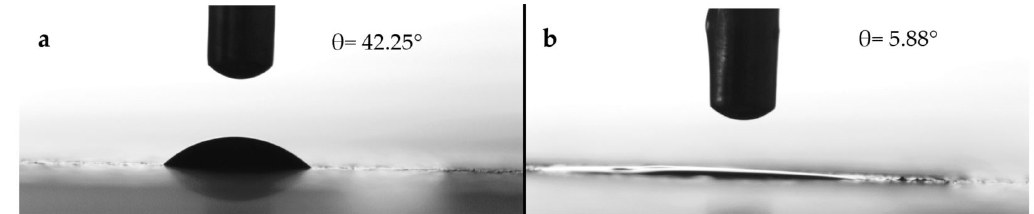
Figure 15. Contact angles obtained in laser texturing for: ( a ) 5 W and 250 mm/s; ( b ) 20 W and 10 mm/s.